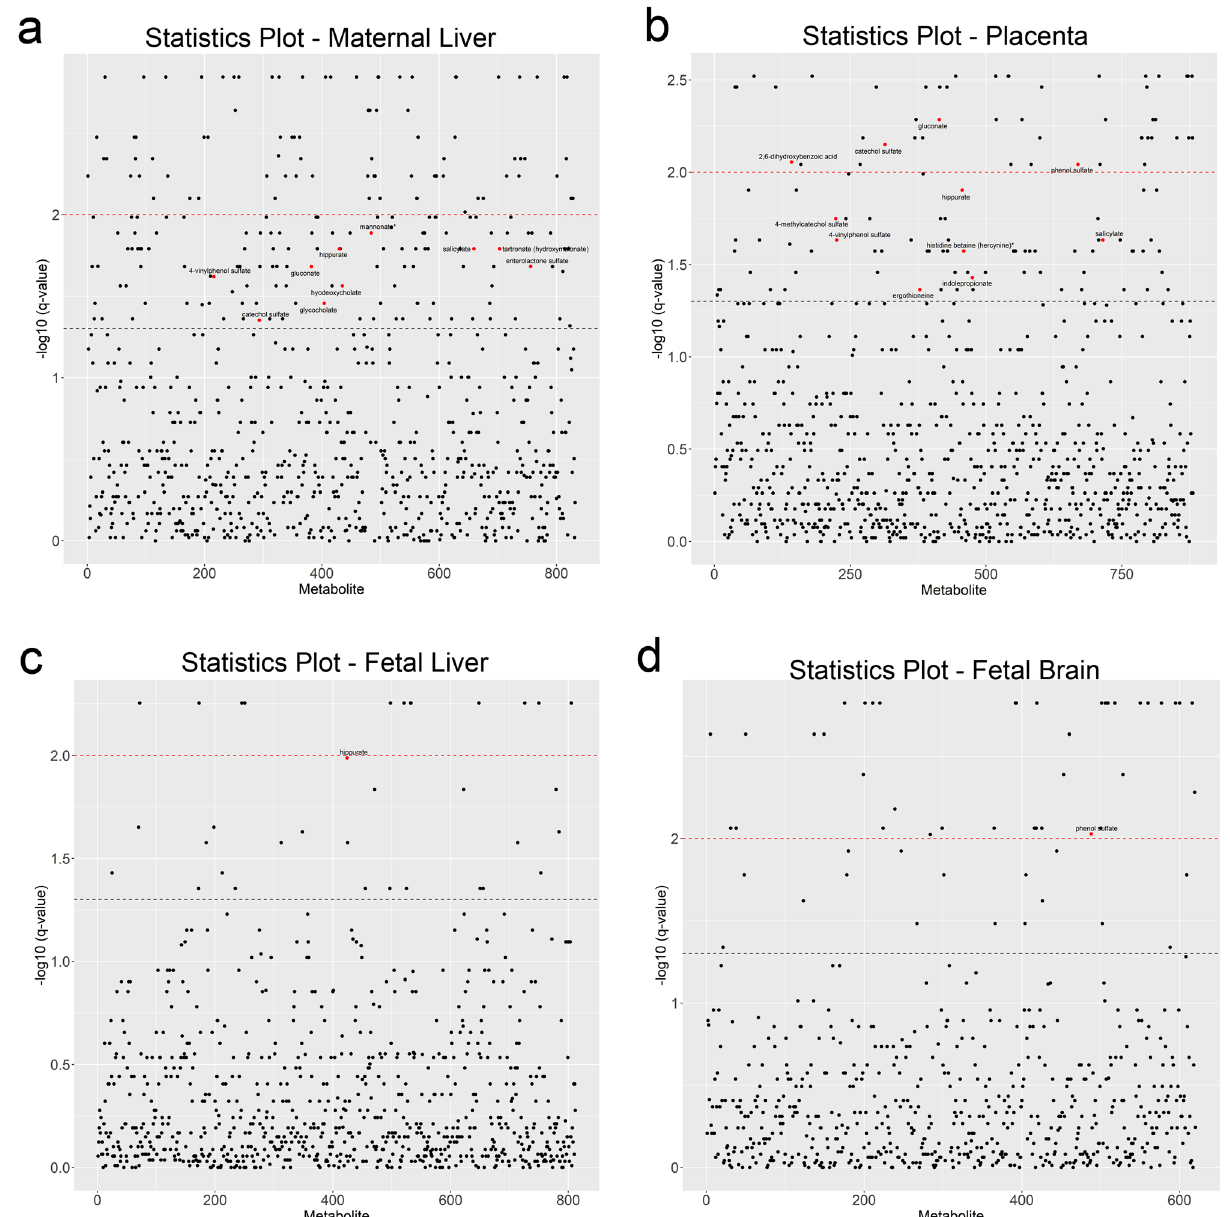
Figure 5. T-Statistic plot of all metabolites present in maternal and fetal tissues, plotted against their − log10 q -values. Metabolites are arranged along x-axis in alphabetical order. The black dashed line indicates the cut-off for the FDR adjusted value of q < 0.05, and the red dashed line indicates q < 0.01. Red dots indicate microbial- derived metabolites having q < 0.05. ( a ) T-statistic plot of the 854 metabolites detected in maternal liver. ( b ) T-statistic plot of the 881 metabolites detected in placenta. ( c ) T-statistic plot of the 854 metabolites detected in fetal liver. ( d ) T-statistic plot of the 621 metabolites detected in fetal brain. Sample size is n = 9 control and n = 8 alcohol-exposed